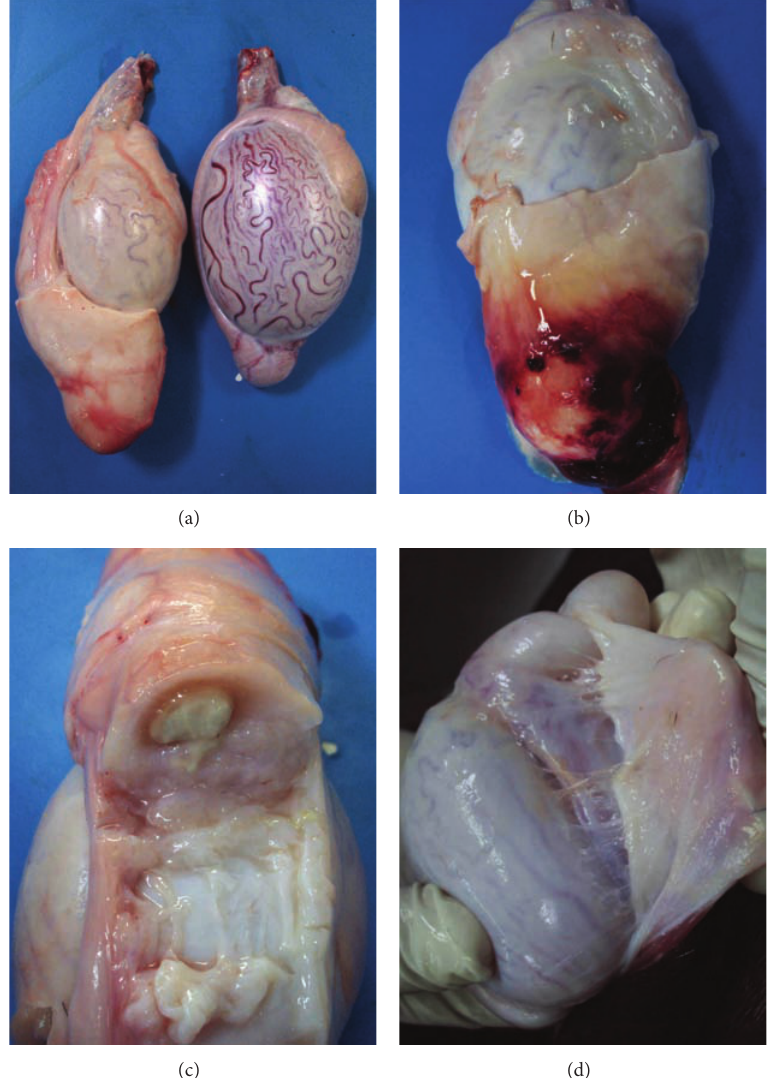
Figure 6: Gross findings in rams experimentally infected by Histophilus somni . ((a) and (b)) Unilateral epididymitis associated with testicular atrophy. (a) The body and tail of left epididymis are severally increased in size with tunica vaginalis adhered and ipsilateral testis strongly decreased. (b) Hematoma in tunica vaginalis adjacent to the tail of the epididymis. (c) Epididymal abscess. Body of left epididymis is increased in size and focal area in cut surface with yellowish viscous material. (d) Chronic periorchitis. Multifocal fibrous adhesions between the tunica albuginea and the tunica